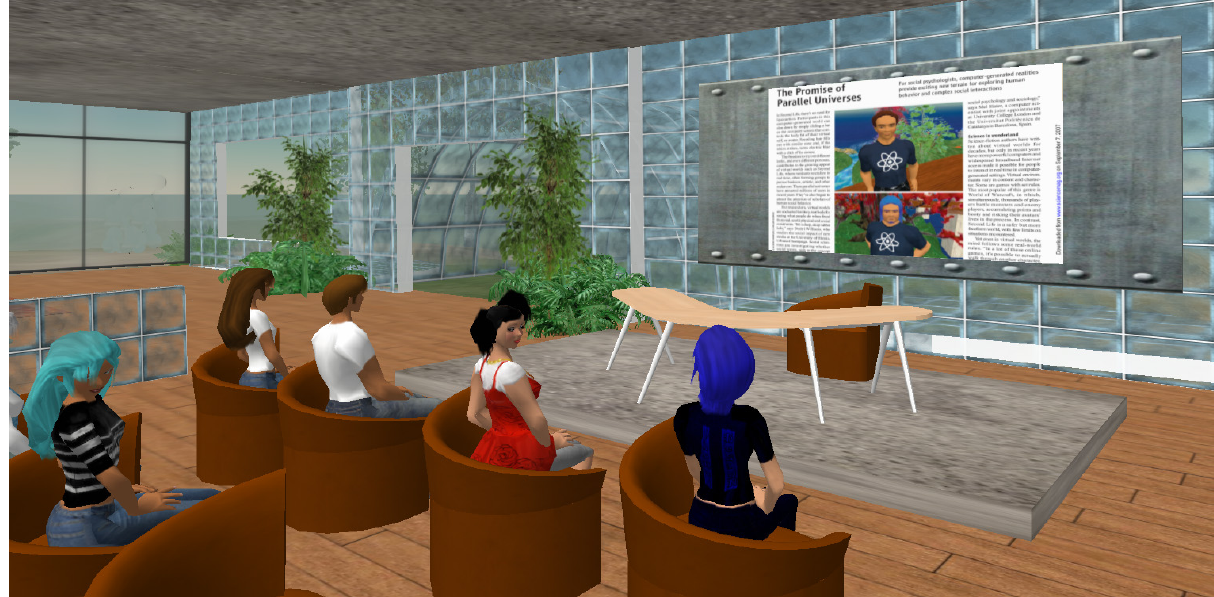
Figure 1. A screenshot from the Learning area [56]